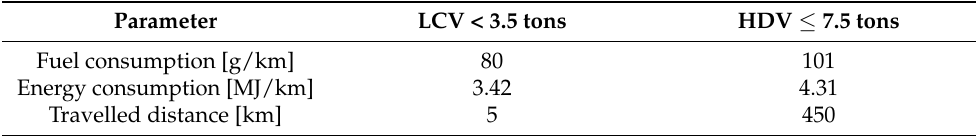
Table 3. Consumption and distance travelled for the cherry transportation. Parameter LCV < 3.5